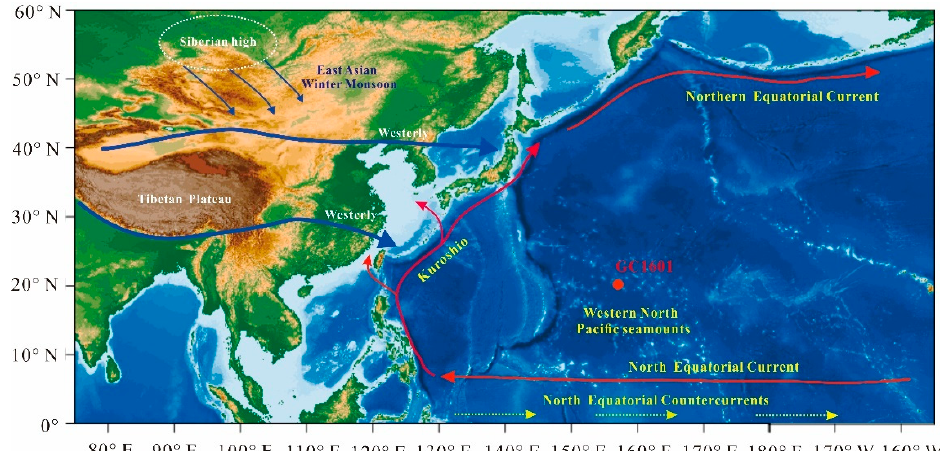
Figure 6. Monsoon and Ocean current in the western Pacific (Modified after [59,60]).